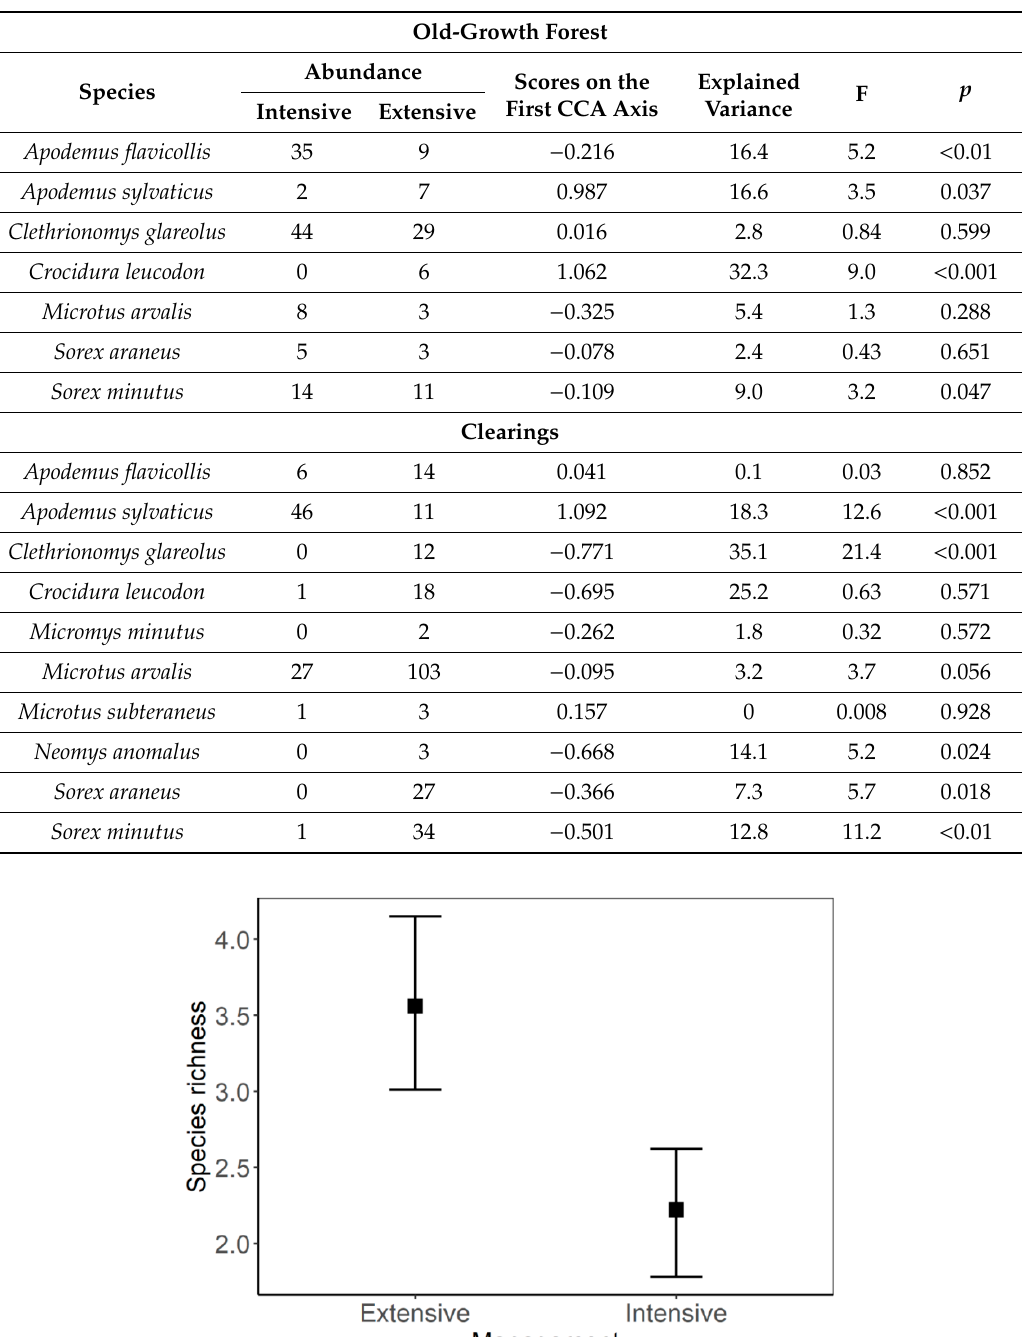
Table 1. Summary table of the analysis of the species response curve visualizing species responses to an environmental gradient (i.e., management intensity) on the first ordination axis. Species response curves were fitted by generalized linear models with Poisson error distribution and a control for overdispersion. Positive scores of species among old-growth forest patches represent a positive association with extensive forest management and vice versa. Positive scores of species among clearing patches represent a positive association with intensive forest management and vice versa.